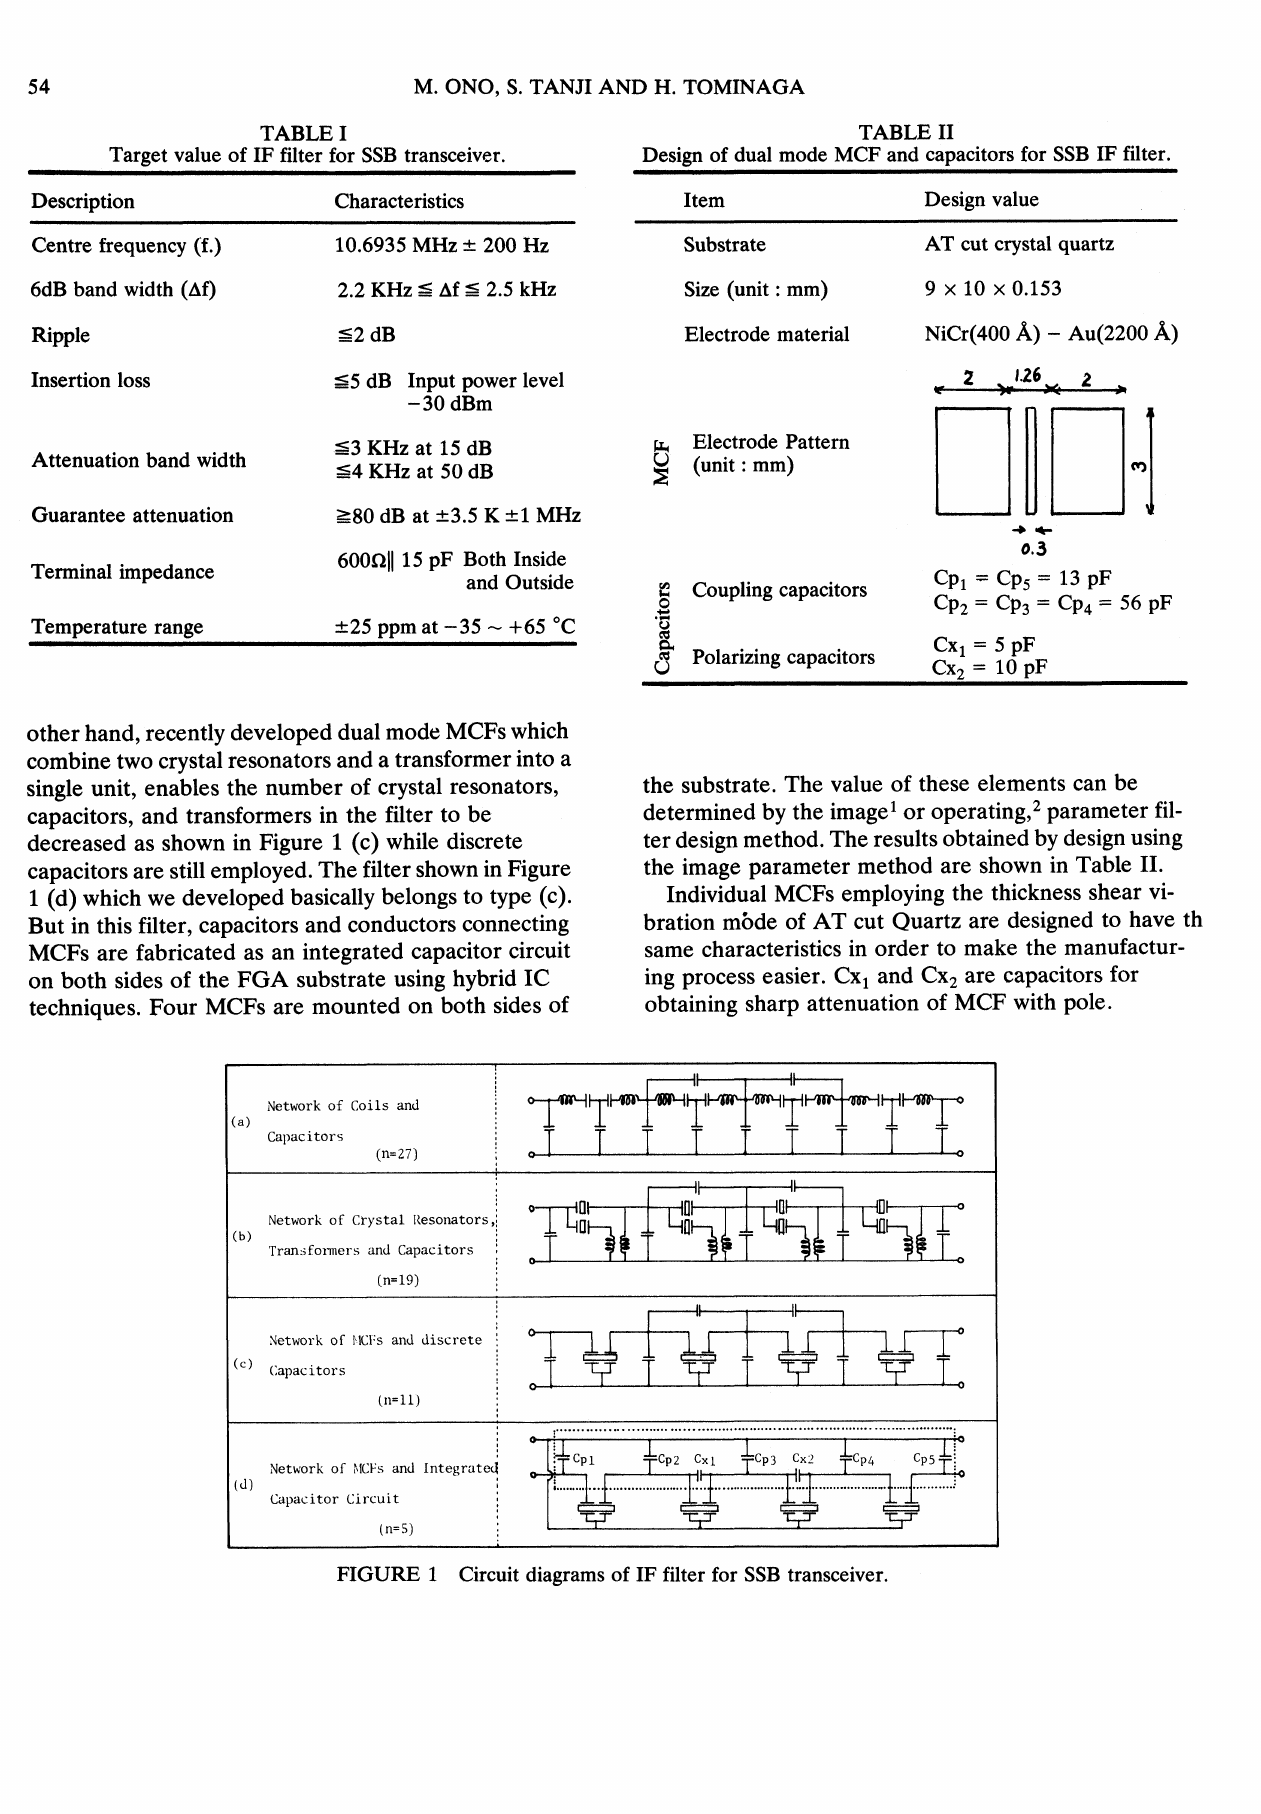
TABLE Target value of IF filter for SSB transceiver.